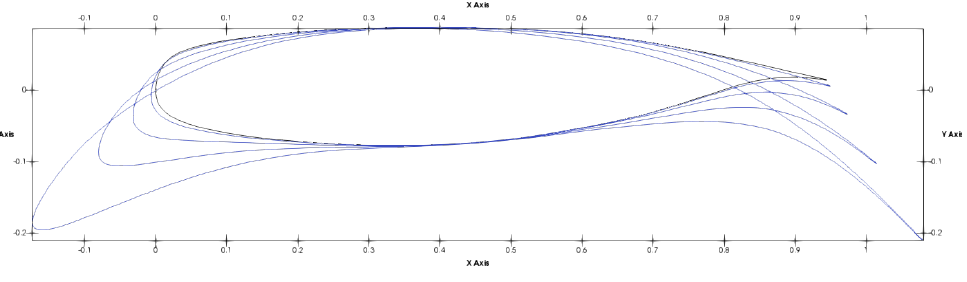
Figure 12. SDO NLR7301 morphing stages.